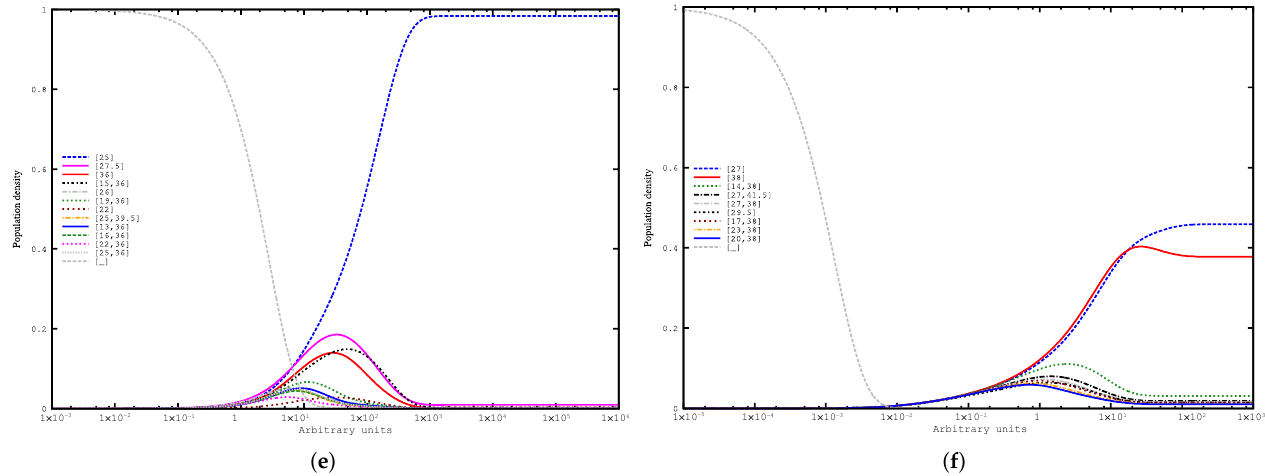
Figure 3. Folding kinetics of ( a ) Leptomonas collosoma spliced leader RNA gene repeat unit; ( b ) Trypanosomatidae sp. ECU-07 trans-spliced leader sequence SL gene; ( c ) Trypanosoma theileri isolate Tthc41 clone 5 trans-spliced leader; ( d ) Trypanosoma sp. bat LL-2013 isolate TCC60 clone 1 trans-spliced leader; ( e ) Trypanosoma livingstonei isolate TCC1933 clone 2 trans-spliced leader; ( f ) consensus folding space calculated with RNA LI H I K INETICS based on sequences; ( a – e ) above. The sequences ( b – e ) were collected by a B LAST N search against the nt database with default settings and sequence ( a ) as